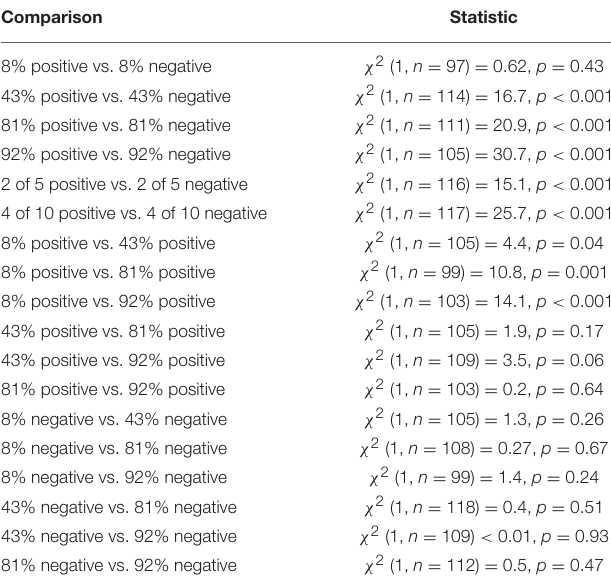
TABLE 9 | Summary of chi-squared analyses for Experiment